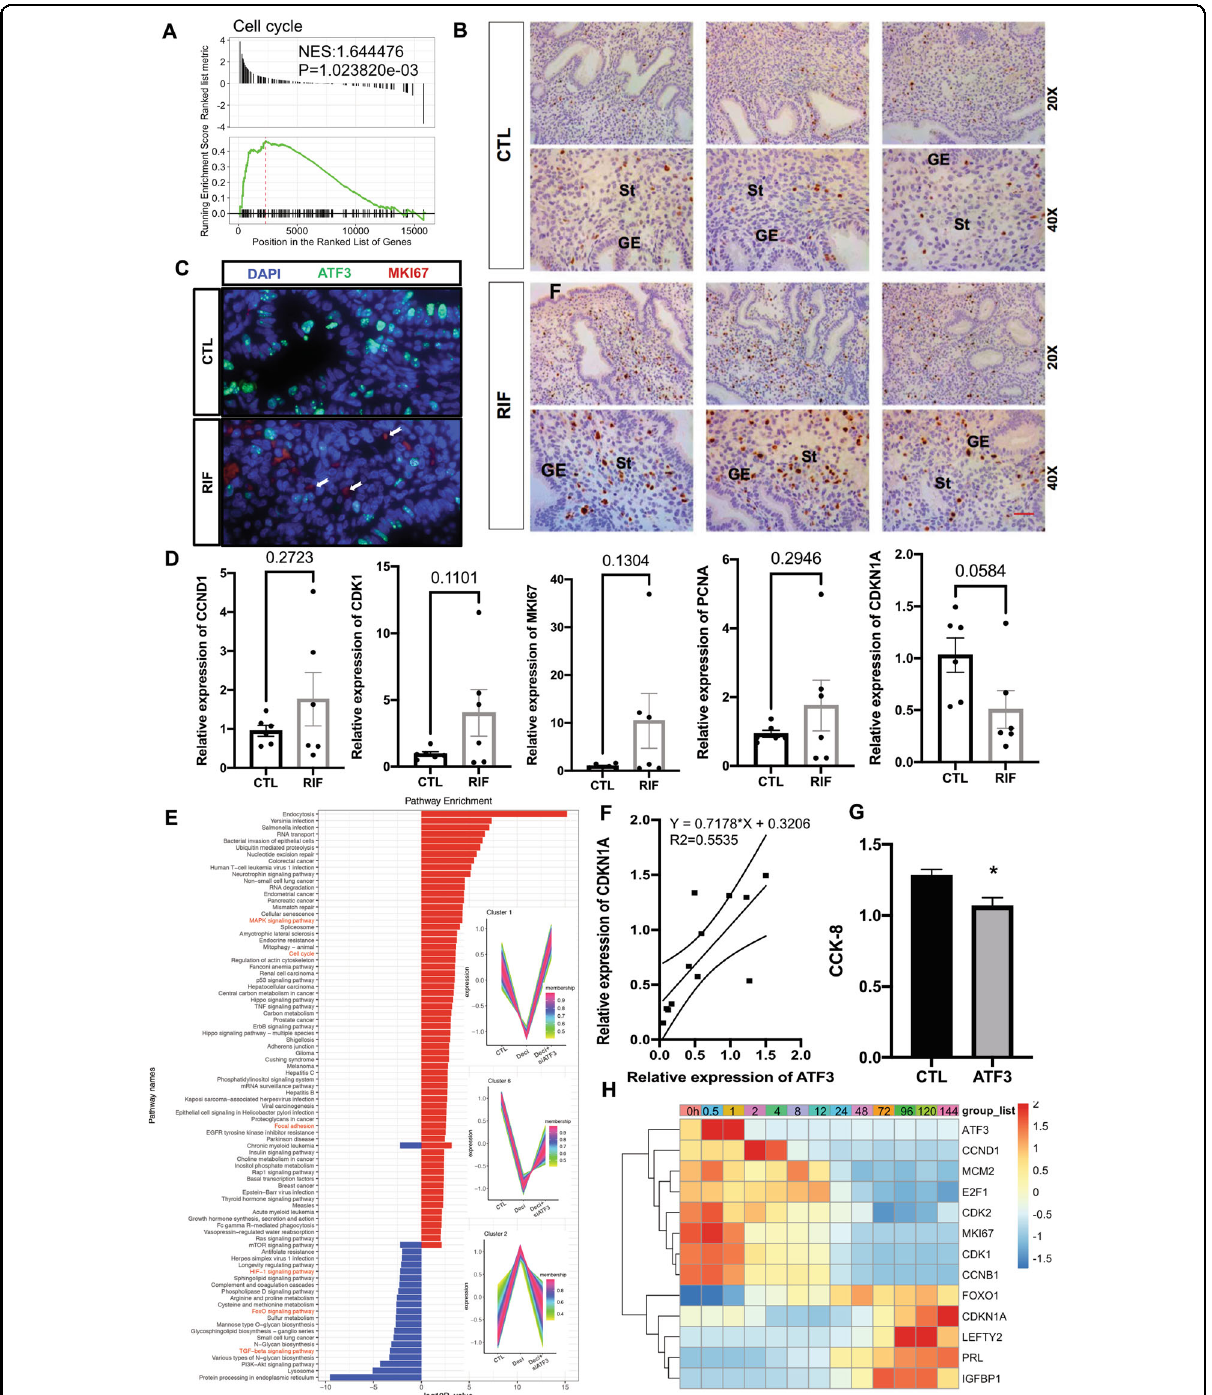
Fig. 6 ATF3 regulates the cell cycle of hESCs. A GSEA results showed that the cell cycle term was activated in the endometrium of RIF patients (NES: 1.644476, P = 1.023820e − 03). B . MKI67 staining was used to measure the proliferation of stromal cells in the endometrium of RIF patients and fertile controls (ST, stromal cells, GE, glandular epithelium, bar = 50 µm, n = 5). C immuno fl uorescence was performed to determine the expression of ATF3 and MKI67 in endometrium from fertile controls and RIF patients. D The cell cycle-regulated genes were measured by qPCR in the endometrium of RIF patients and fertile controls, n = 6. E TC-seq analysis was performed to analyze the DEGs in the control, decidualization, and siATF3 + decidualization groups. Genes in clusters 1 and 6 were upregulated by siATF3, while those in cluster 2 were downregulated. F The correlation of ATF3 expression and CDKN1A. G hESCs were treated with Ad-ATF3-His or Ad-LacZ, and a CCK-8 assay was performed to detect the cell proliferation rate. H Genes related to cell proliferation and decidualization change regularly during in vitro-induced